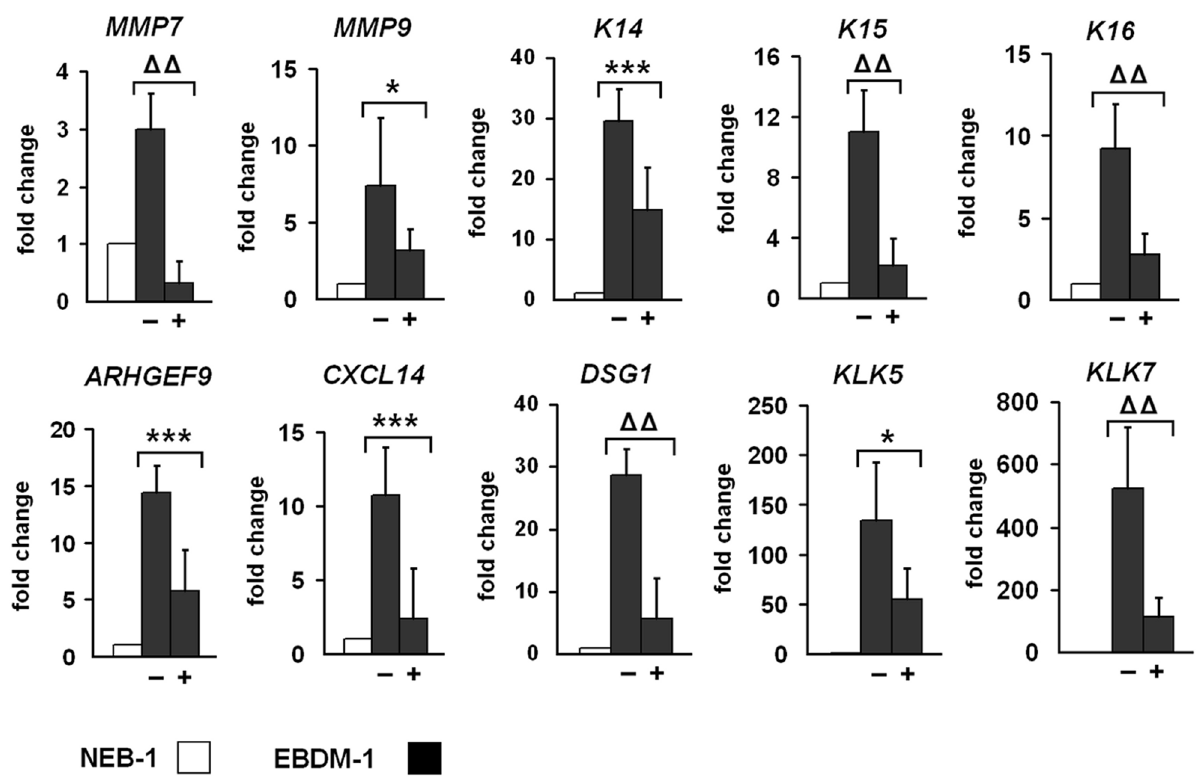
Figure 7. Reduced expression of target genes upon IL-1 b depletion. NEB-1 cells and EBDM-1 cells were incubated with 2 m g/ml IL-1 b neutralizing antibody for 24 h to deplete IL-1 b in the culture medium. Expression of untreated EBDM-1 cells ( 2 ) was compared to treated EBDM-1 cells ( + ) by SQRT-PCR. We picked at least one representative target gene of each of the six functional groups identified in the microarray. All investigated targets showed significant downregulation after IL-1 b depletion. No differences in geneexpression were observed in NEB-1 cells 2 / + antibody incubation (n=3). Student’s t -test was performed with p values: * # 0.05, *** # 0.005, DD # 0.0005.